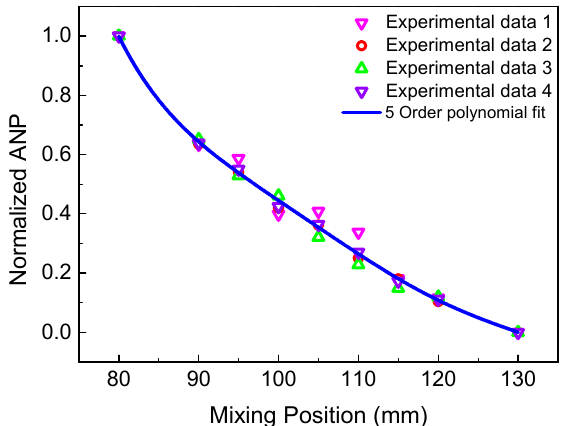
Figure 17. Normalized ANP of the 6 MHz resonant wave versus mixing position with non-fatigue experiment.